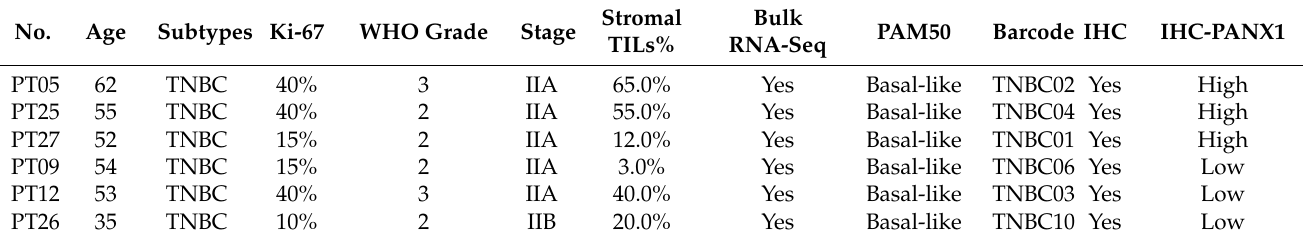
Table 2. Clinical characteristics of the included samples for